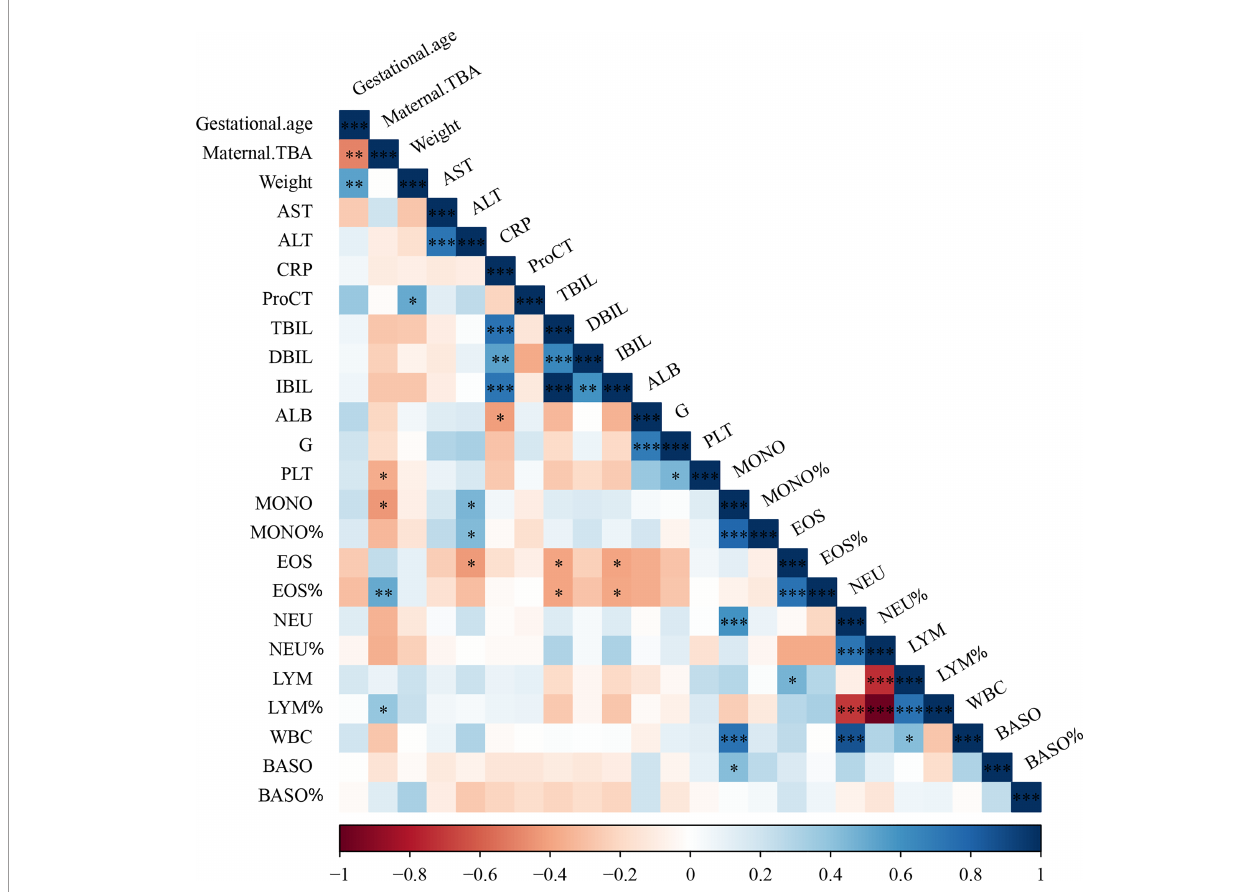
FIGURE 1 | Cholestatic pregnancy is associated with hematologic parameters in the offspring. TBA, total bile acid; AST, aspartate aminotransferase; ALT, alanine transaminase; CRP, c-reactive protein; ProCT, procalcitonin; TBIL, total bilirubin; DBIL, direct bilirubin; IBIL, indirect bilirubin; ALB, albumin; G, globulin; PLT, Platelets; MONO, monocyte; EOS, eosinophil; NEU, neutrophil; LYM, lymphocyte; WBC, white blood cell; BASO, basophil; * p<0.05; ** p<0.01; *** p<0.001.